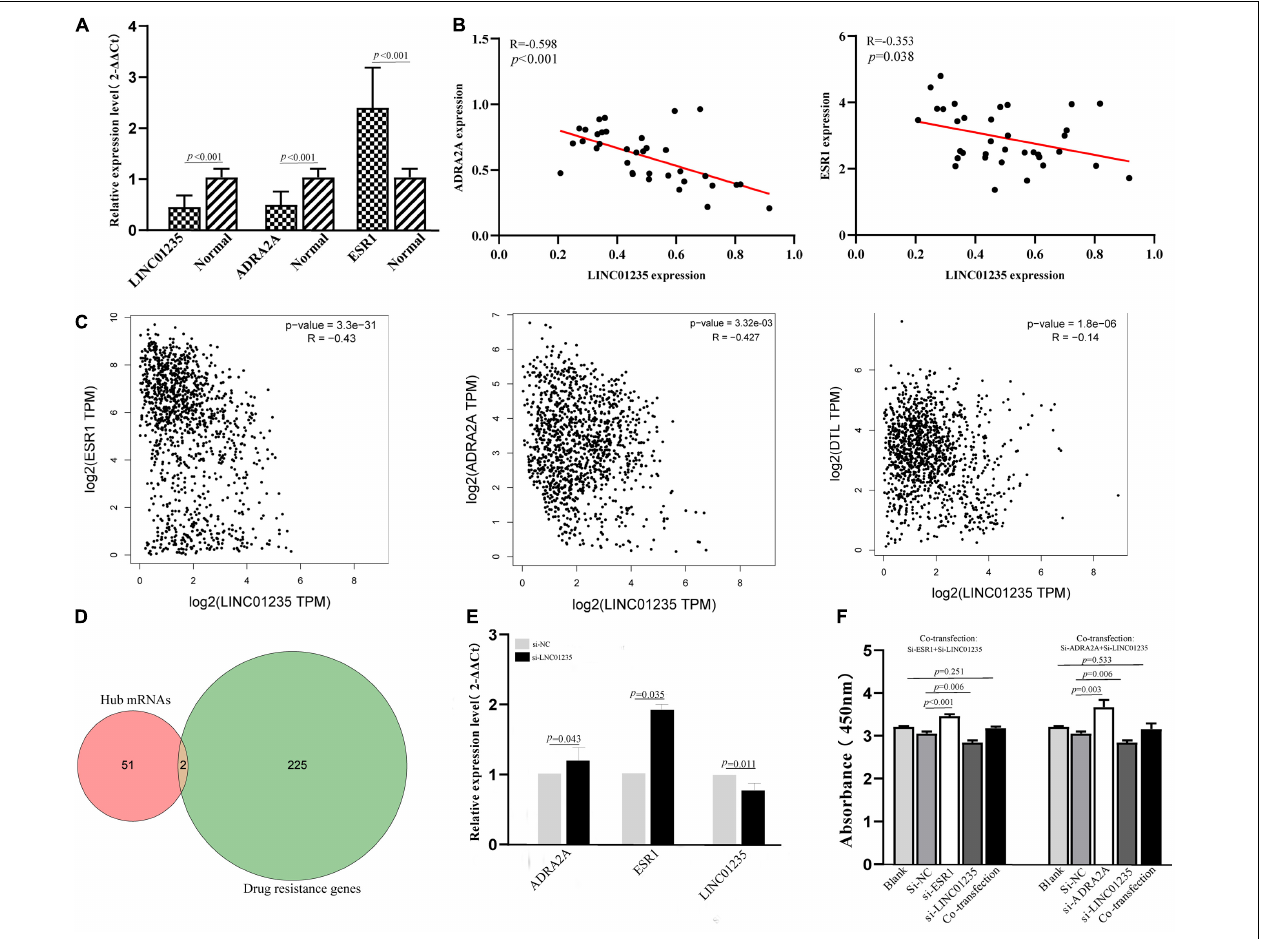
FIGURE 7 | (A) Real-Time Quantitative Reverse Transcription Polymerase Chain Reaction analysis was conducted to assess the expression levels of LINC01235, ESR1, and ADRA2A in 35 paired breast cancer tissues and their corresponding adjacent normal tissues. The data were shown as mean ± standard deviations. (B) The correlation between the expression of LINC01235 and the expression of ESR1 and ADRA2A. (C) The expression correlation between LINC01235-ESR1 and LINC01235-ADRA2A through clinical samples. The correlation between the expression of LINC01235 and the expression of ESR1, DTL, and ADRA2A using GEPIA (http://gepia2.cancer-pku.cn/#index). (D) Venn diagram shows the overlapping mRNAs of hub mRNAs in the PPI network and breast cancer drug resistance mRNAs. (E) Expression change of ESR1 and ADRA2A after silencing expression of LINC01235 in the MCF-7 cell line. (F) The effects of si-ESR1, si-ADRA2A,